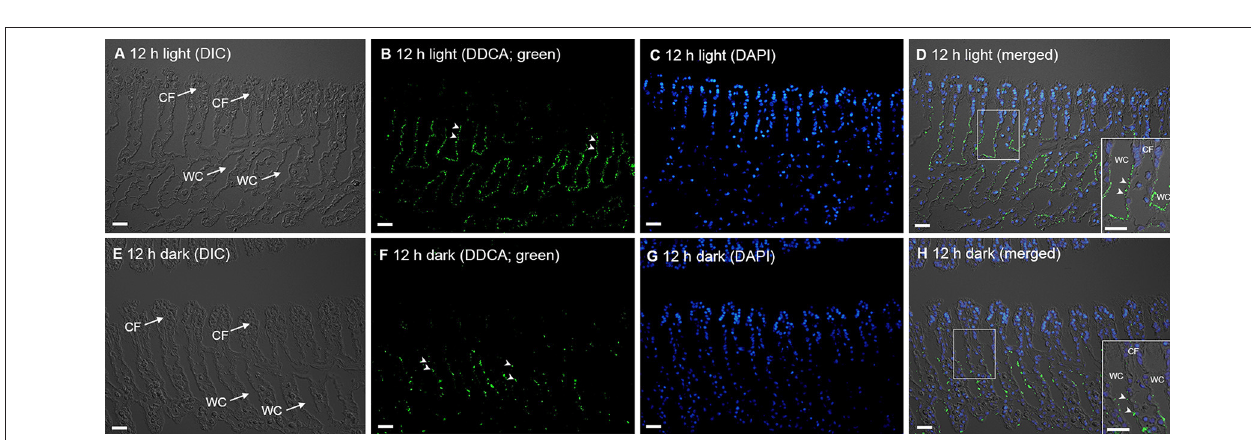
FIGURE 7 | Immunofluorescence localization of the Dual Domain Carbonic Anhydrase (DDCA) in the ctenidial filaments (CFs) of the ctenidium of Tridacna squamosa . Immunofluorescence localization of the DDCA in the CFs of T. squamosa exposed to 12h of light (A–D) or 12h of darkness (control; E–H ). Differential interference contrast (DIC) images show the structure of CFs (A,E) . Anti-DDCA immunofluorescence is shown in green (B,F) with nuclei counterstained with DAPI in blue (C,G) . Green and blue channels are merged and overlaid with the respective DIC images (D,H) . Arrowheads indicate DDCA-immunostaining at the apical membrane of the epithelial cells located at the base of CFs and those surrounding the tertiary water channels (WCs). Scale bar: 20 µ m. Reproducible results were obtained from four individual clams for each experimental